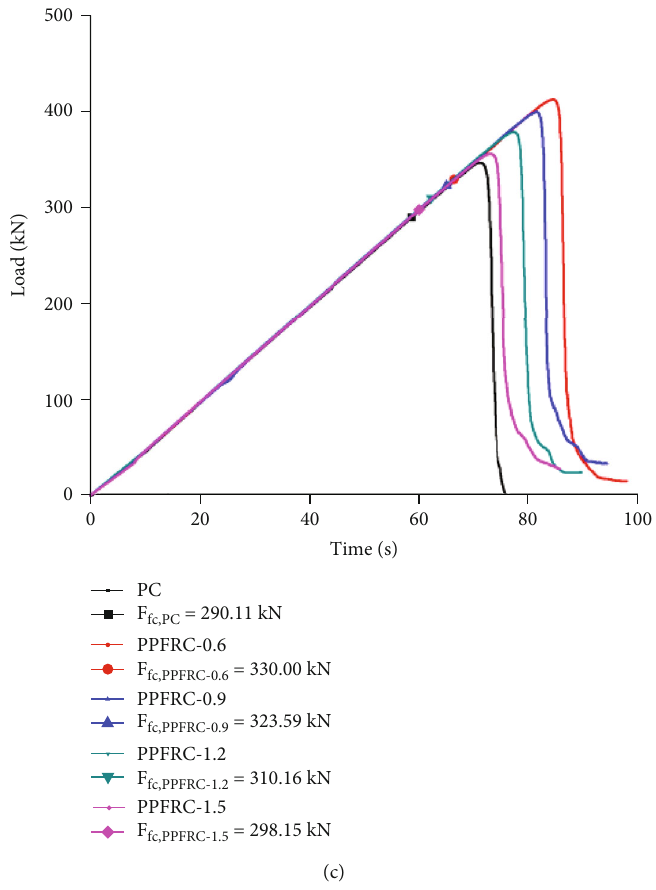
Figure 9: Load – time curves of PC and PPFRC from compressive test: (a) 14 days, (b) 28 days, and (c) 60